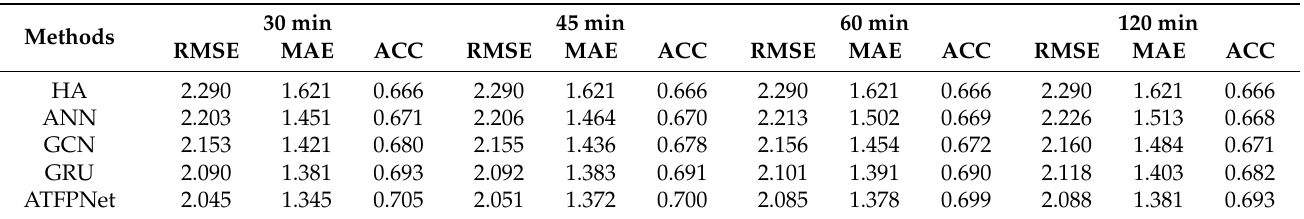
Table 5. The prediction results of the ATFPNet and other baseline methods on the real-world airport traffic flow dataset from the